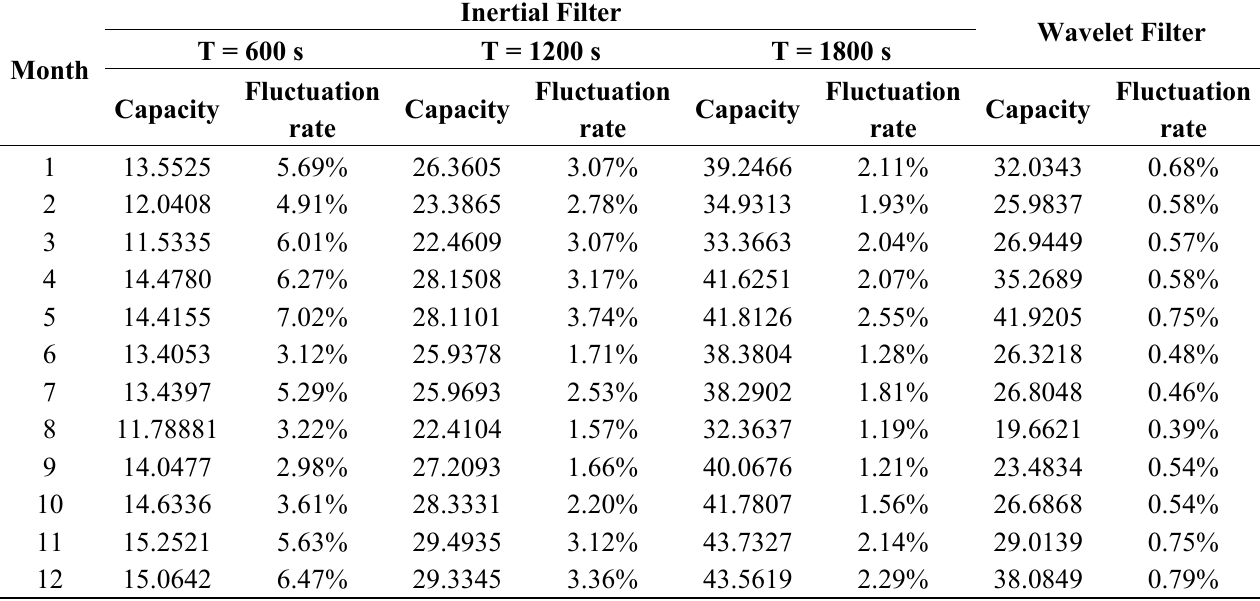
Table 2. The battery capacity allocations used for a wind farm every month